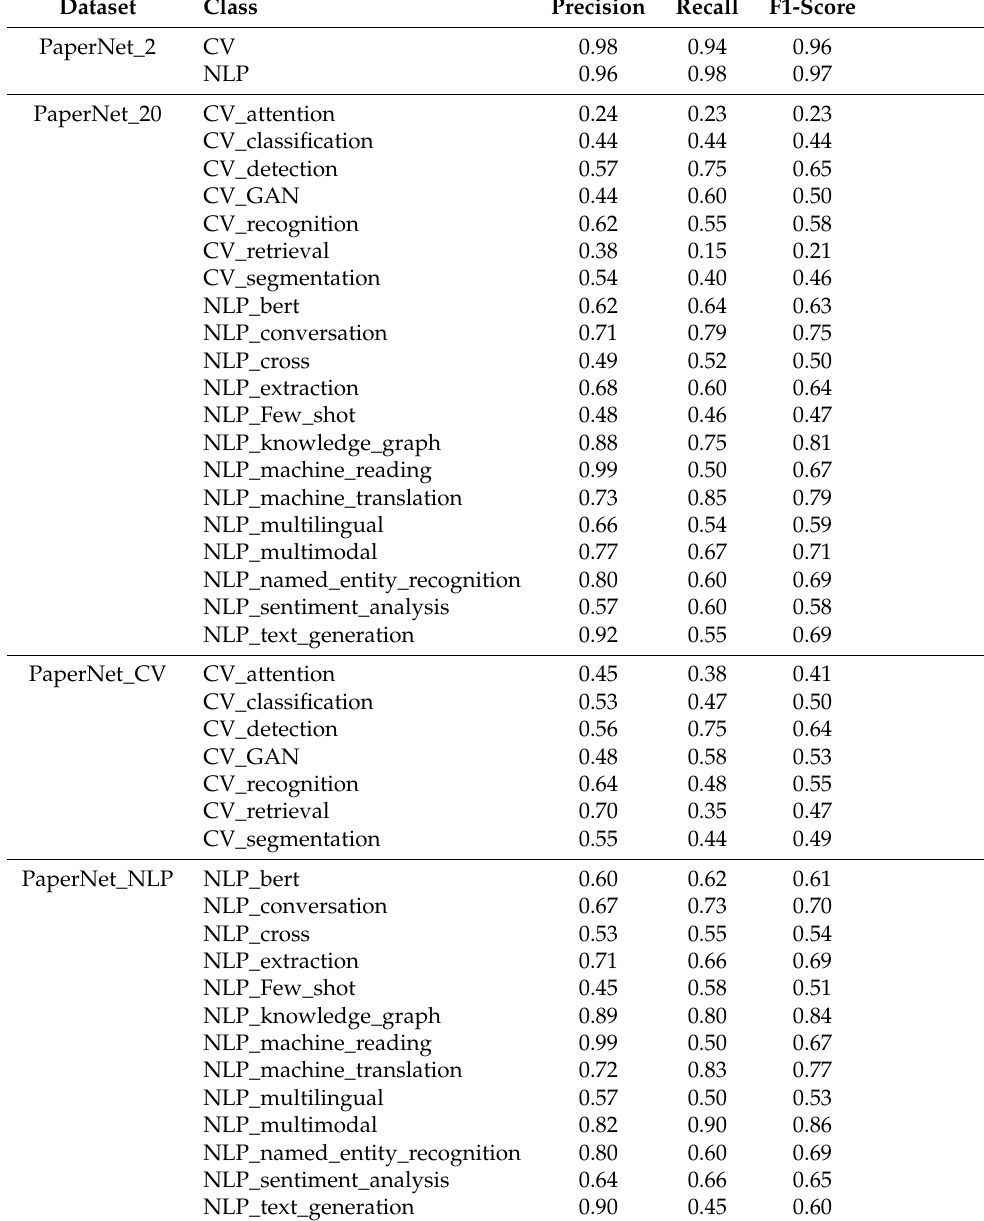
Table A3. Detailed results of the KNN